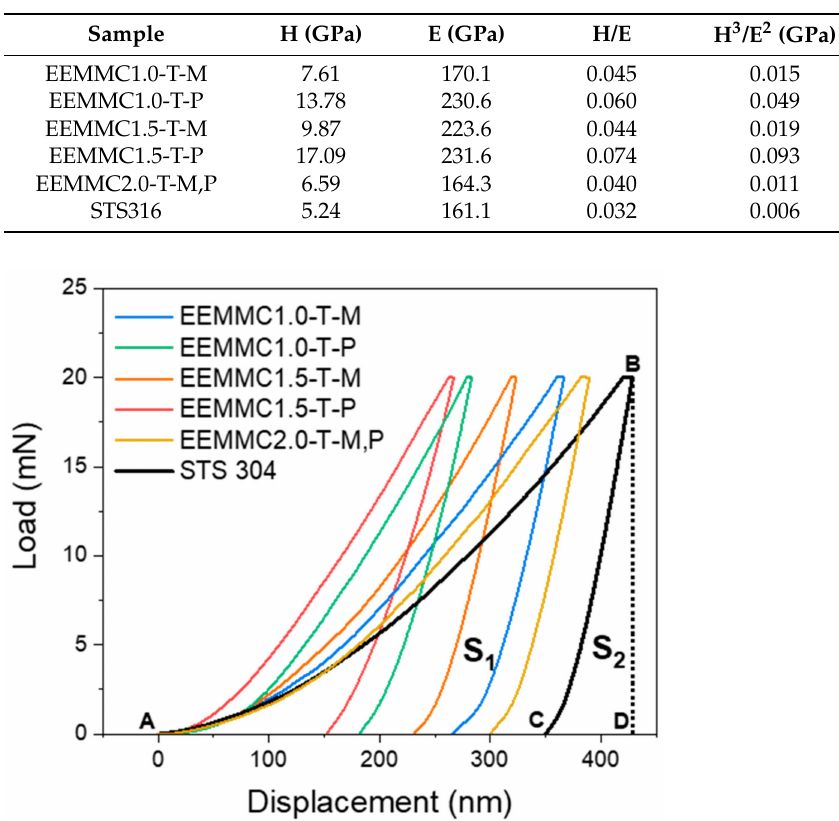
Figure 11. Micro-Vickers hardness profile measured in-depth direction from the surface of a coating layer. Table 5. Mechanical properties of the coatings measured using nano-indentation.